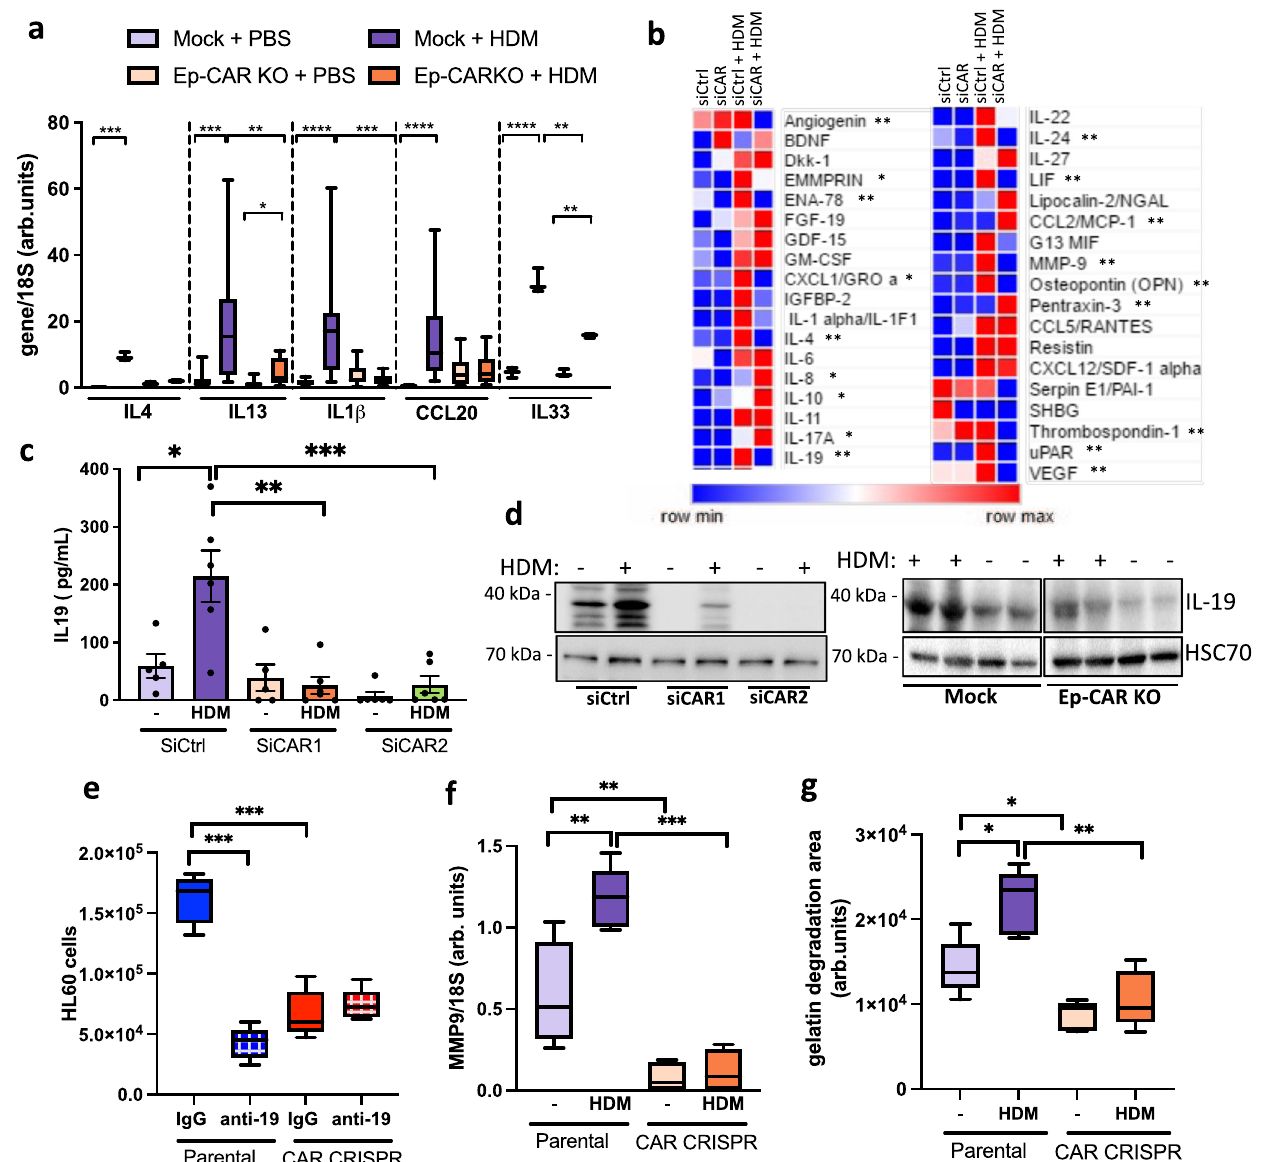
Fig. 2 | Lung epithelial CAR contributes to cytokine secretion pro fi les. a Levels of IL4, IL13, IL1b, CCL20 and IL33 transcripts from lung extracts speci fi ed animal groupsmeasuredbyqPCR.Dataispooledfrom3independentinvivoexperiments with 5 mice per group per experiment. b Summary of results from cytokine array from 16HBE siControl or siCAR cells±HDM for 24h. Asterisks indicate signi fi cant changesinCARdepletedcells+HDMcomparedtocontrolcells+HDM c IL-19levels in supernatants of 16HBE cells±HDM for 24h as measured by ELISA. Graph shows pooled date from 6 replicates, representative of 3 independent experiments. d Westernblotsoflysatesfrom16HBEasin c orhomogenatesfromtotallungsfrom MockorEp-CARKOmiceprobedforlevelsofIL-19andGADPH.Representativeof4 experiments for each. e Transmigration of HL60 cells in response to supernatants